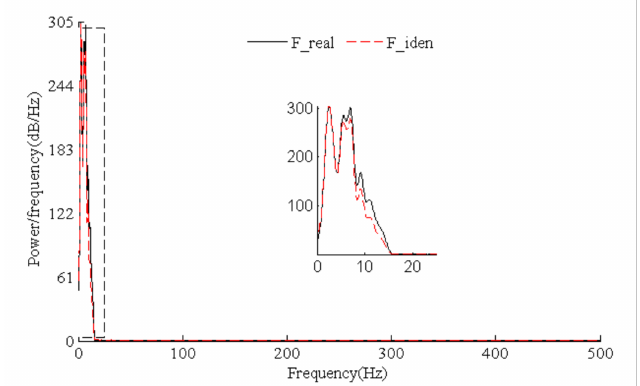
Figure 18. Identified and real PSDs for test random loads.